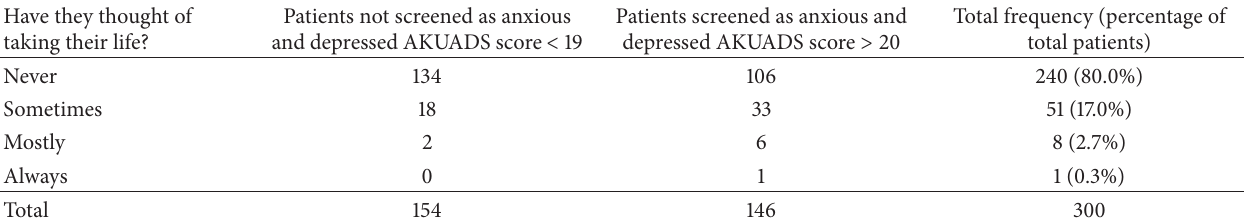
Table 2: Frequency of suicidal